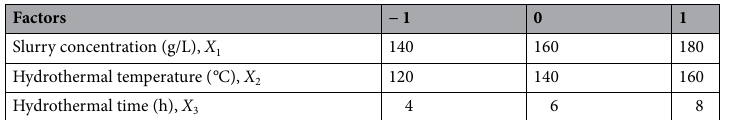
Table 1. Factors and levels of BBD experiments for hydrothermal conditions optimization for high purity